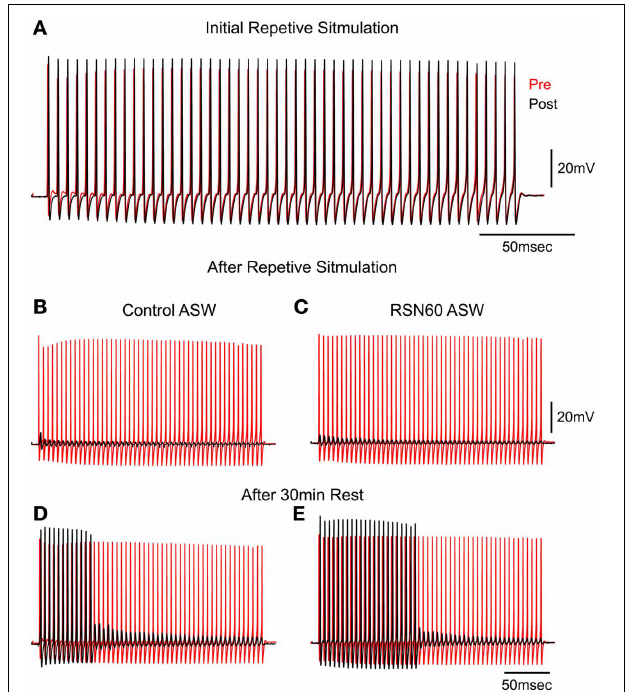
FIGURE 2 | High frequency stimulation in Control and RNS60 ASW. (A) Presynaptic (red) and Postsynaptic (black) spikes generated by a repetitive presynaptic electrical stimulation at 200Hz. (B) Failure of all postsynaptic spike generation after 100 consecutive trains repeated at 1Hz in Control ASW. (C) Same as in (B) recorded in RNS60 ASW. (D) Partial recovery of postsynaptic spike generation after a 30s rest period in control ASW. (E) Partial recovery after rest period in RNS60 ASW. Note in (D,E) that in the presence of RNS60 ASW there was a more vigorous recovery of postsynaptic spike generation after a similar 30s rest period than in control ASW. Similar results were obtained in four other synapses utilizing the same stimulus